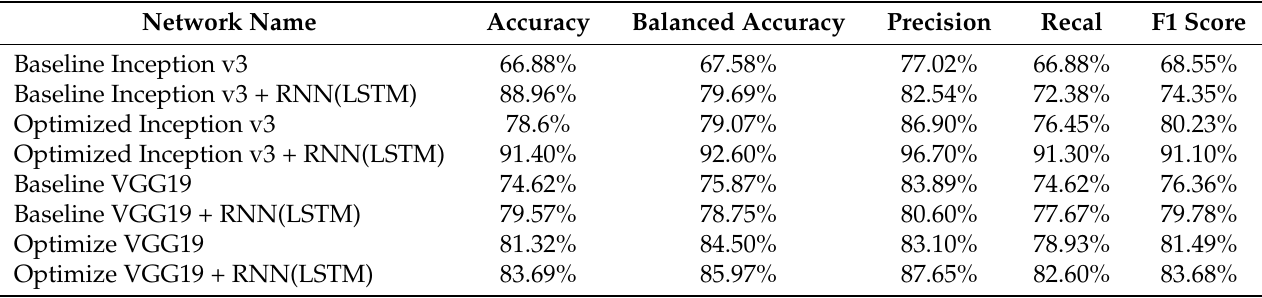
Table 5. All methods accuracy